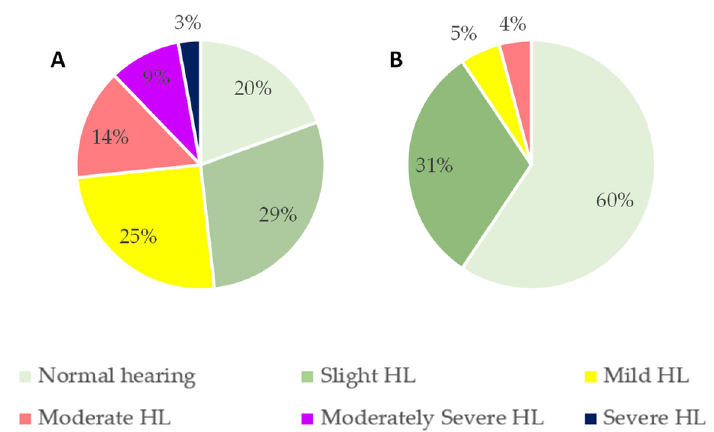
Figure 2. Classification of hearing loss (HL) sorted by age groups according to the American Speech– Language–Hearing Association (ASHA) classification: ( A ) <40 years old; ( B ) ≥ 40 years